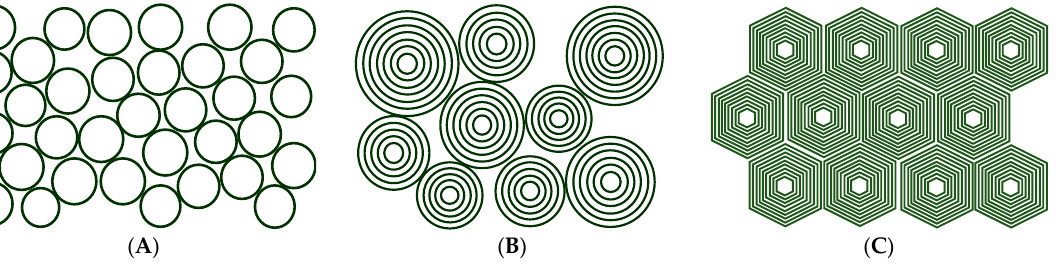
Figure 2. Sketch of different types of densely packed vesicle gels. ( A ) made up from unilamellar vesicles (ULVs); ( B ) made up from multilamellar vesicles (MLVs); ( C ) densely packed deformed vesicles at high concentration.